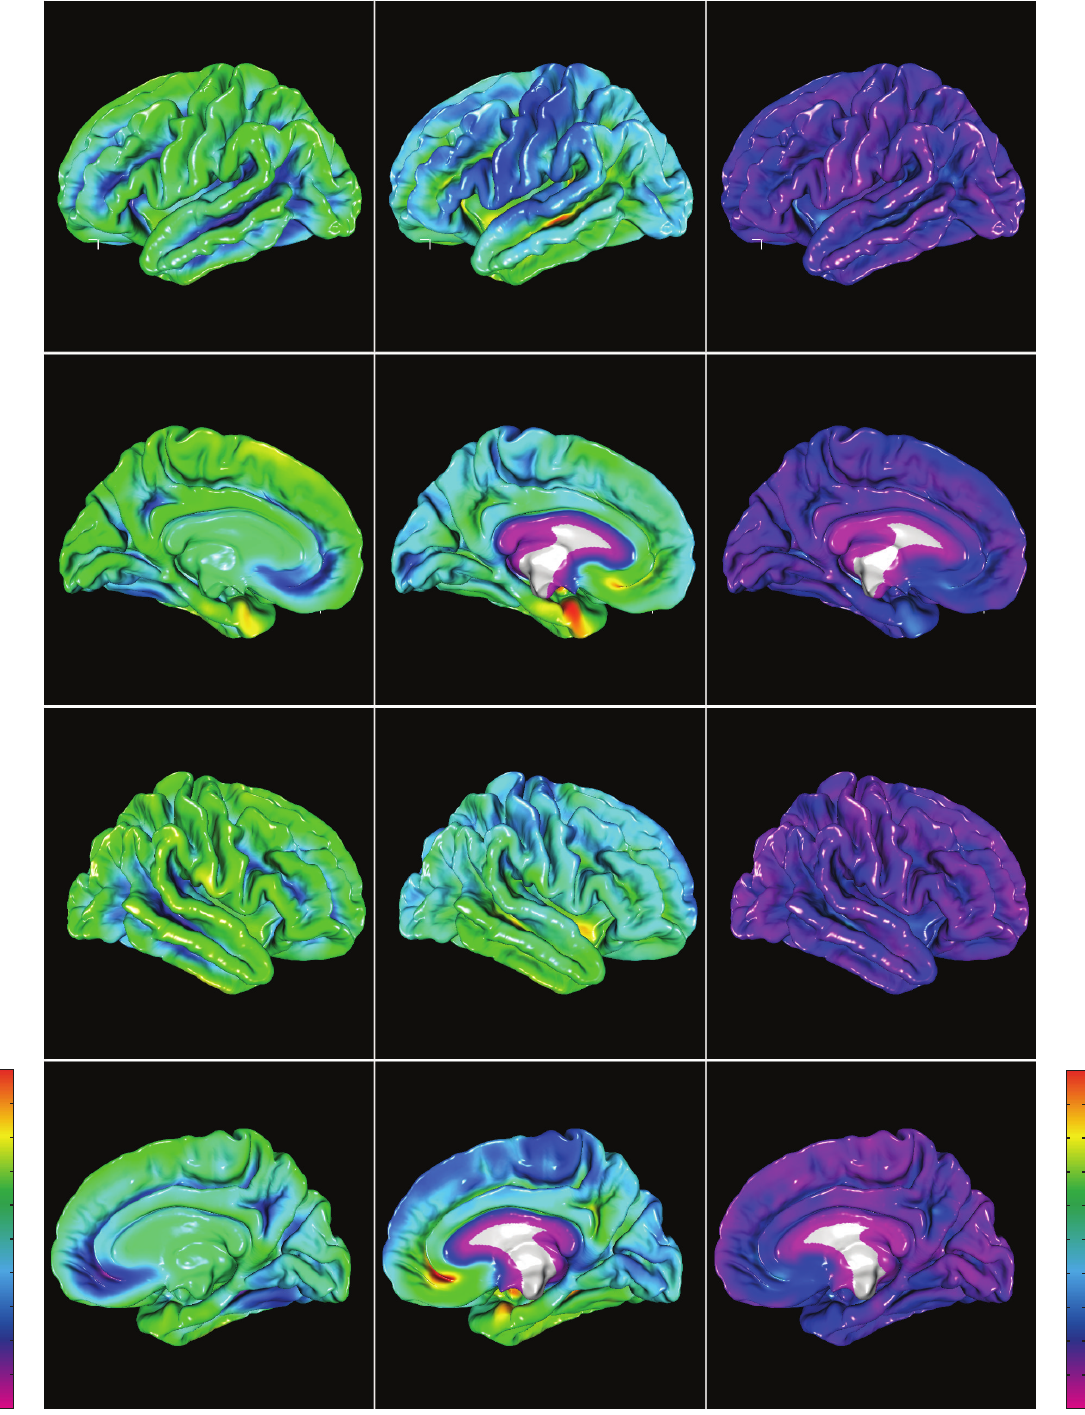
Figure 11: Group-average maps of intermethod (DELFMAP-FreeSurfer) geometric di ff erences in pial surface reconstructions, resampled to FreeSurfer’s average template (left column: signed distance mean, colorbar range ± 1 mm, negative/positive values mean FreeSurfer’ surface is inside/outside of DELFMAP’ surface, resp.; middle column: absolute distance mean, colorbar range 0-1mm; right column: absolute distance stdev., colorbar range 0-1mm; rows 1–4: lateral/medial surface of left/right hemisphere,